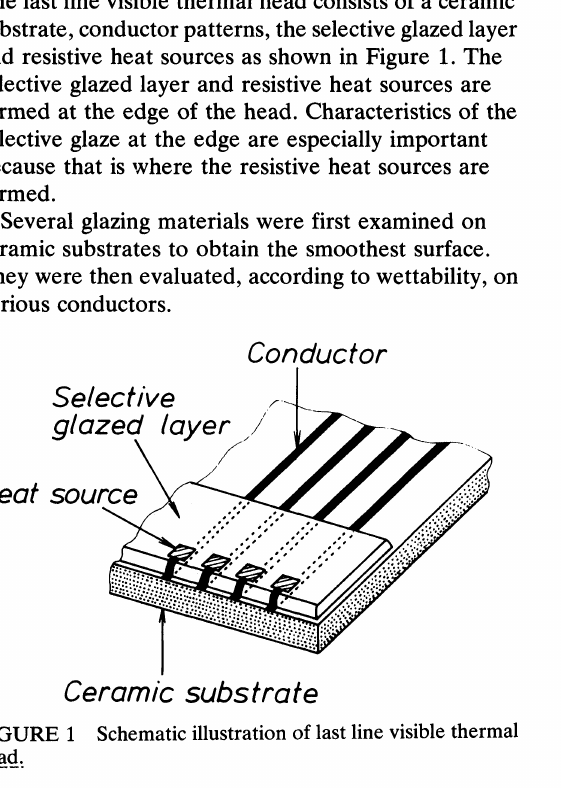
Schematic illustration of last line visible thermal head.